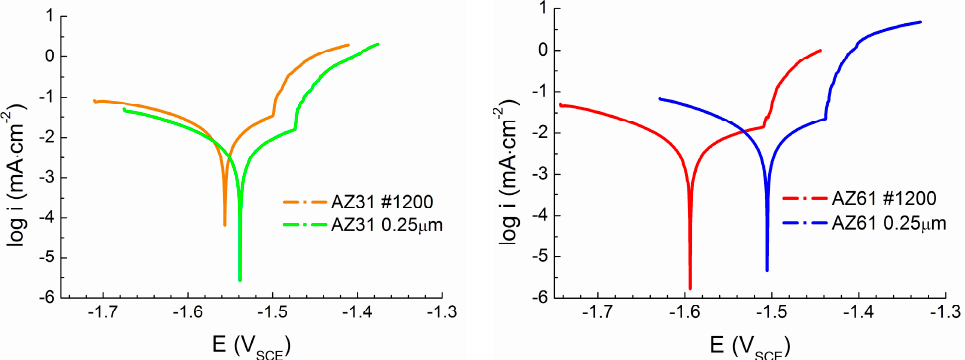
Figure 3. Potentiodynamic curves of ground (#1200) and polished (0.25 µm) surface of AZ31 and AZ61 magnesium alloys in enriched HBSS+ (with Mg 2+ and Ca 2+ ions).